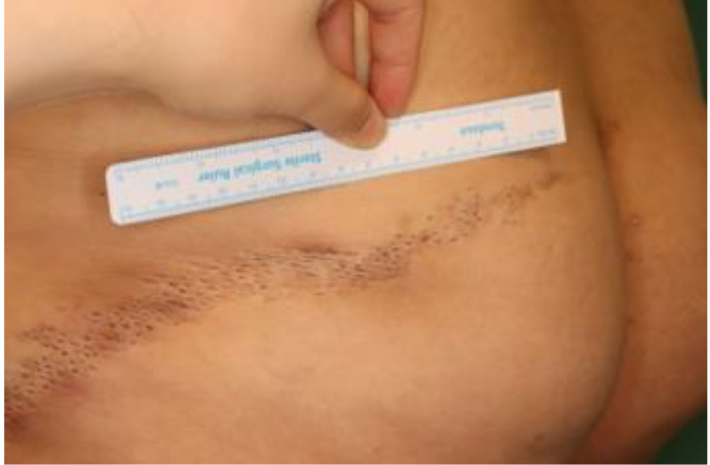
Figure 1. The characteristic appearance of nevus comedonicus. Grouped, linear distribution of comedo-like dark plugs on the left buttock of 31-year-old